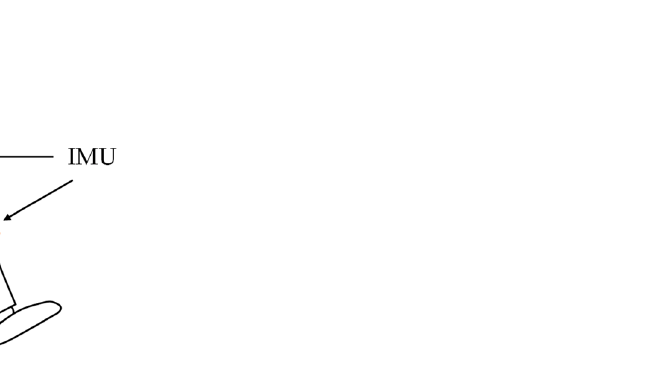
Figure 1. Position of inertial measurement units (IMUs). IMUs were fixed to the sacrum, the bilateral anterior thigh, and shank.